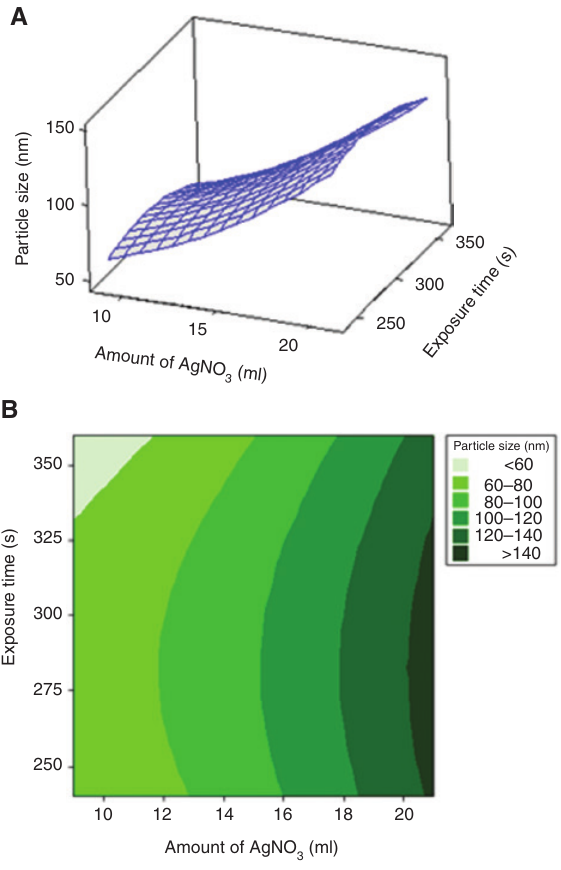
Figure 3: Surface plot (A) and contour plot (B) for the mean particle size of produced AgNPs solution as a function of signifi- cant (p < 0.05) interaction effects of microwave exposure time and amount of AgNO 3